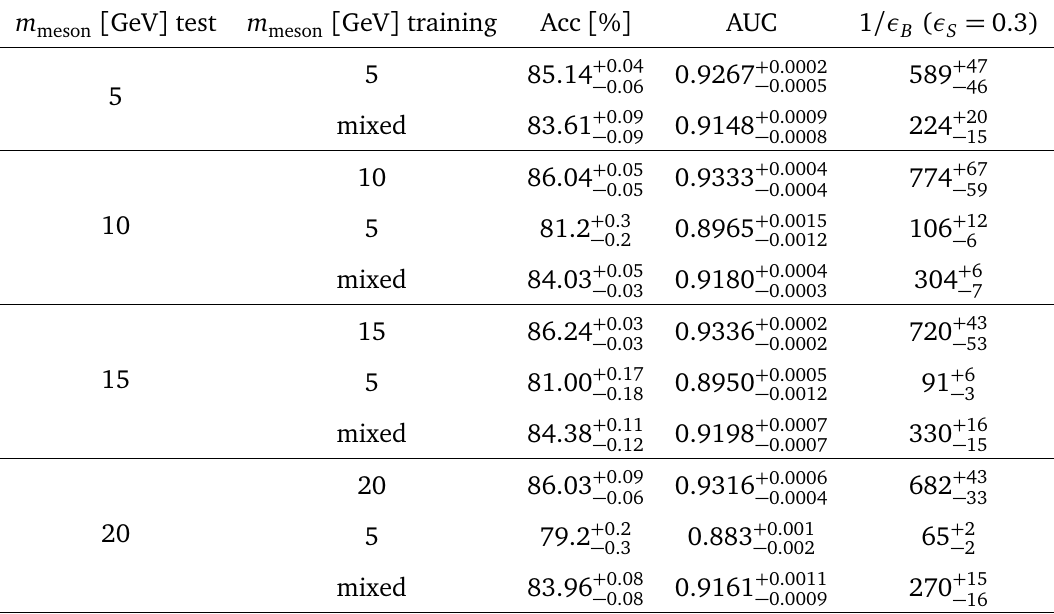
Table 2: Performance measures for the DGCNN for different dark meson masses. We show the performance for networks trained and tested on the same m = 5 GeV, and trained on a mixed sample, corresponding to the ROC curves on m meson in the right panels of Figs. 4, 5, and 6. We show the accuracy, the AUC value and the background rejection at a signal efficiency of 30%. The central value is the mean of five independent training runs, while the error estimate corresponds to the spread in the